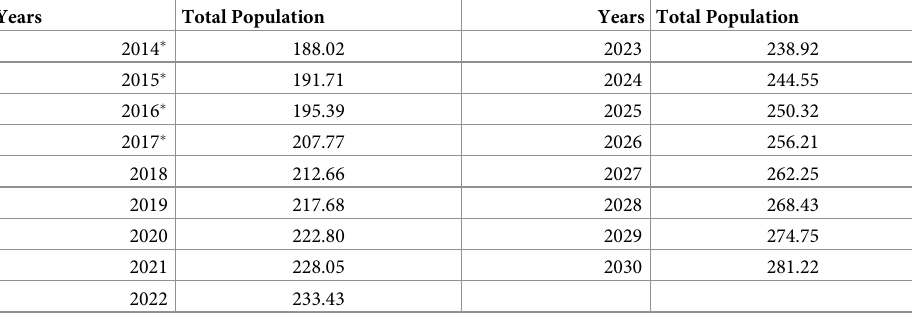
Table 12. Total projected population from 2018 to 2030.